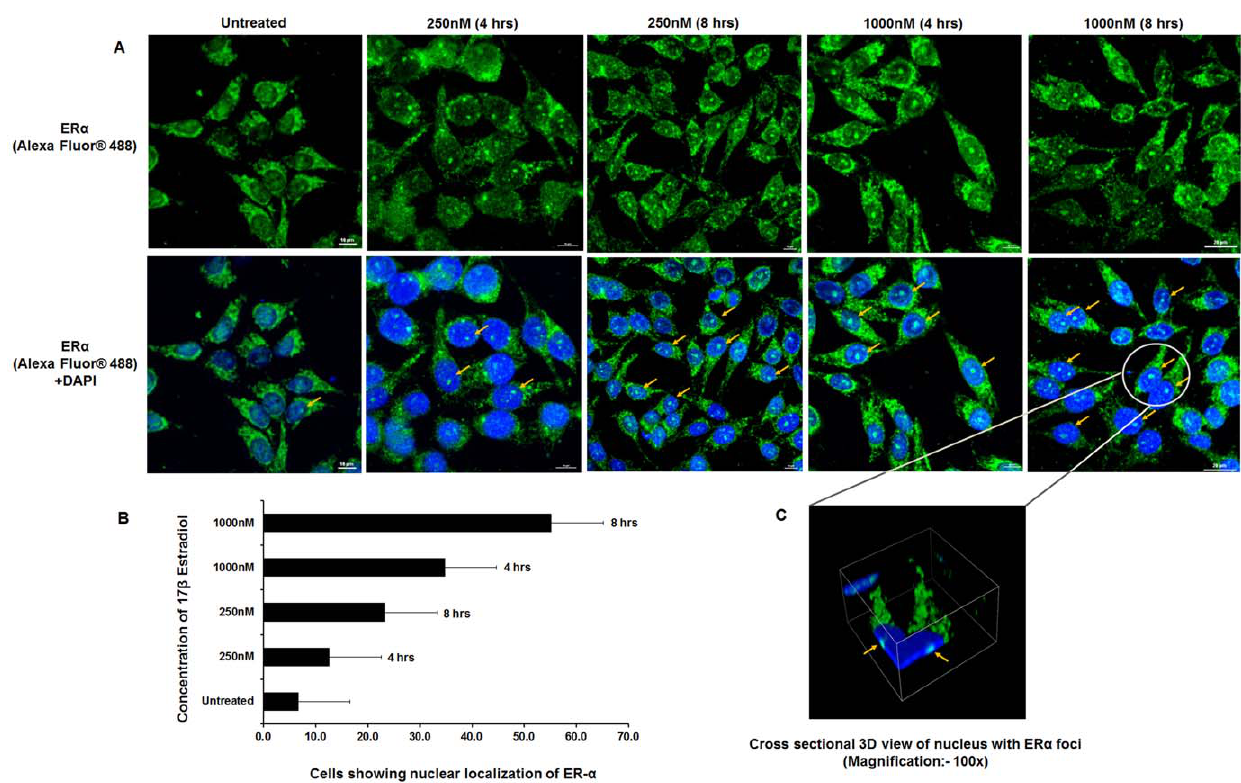
Figure 5. Nuclear localization of ER a upon 17 b estradiol treatment in human RPE cells. A : Confocal images of human RPE cells upon dose (250 mM & 1000 mM) and time (4 hr and 8 hr) dependent treatment with 17 b estradiol. Cells were stained with human specific ER a -antibody followed by Alexa Fluor H 488 labeled anti-rabbit secondary antibody ( Upper panel ). For all conditions, corresponding superimposed image with DAPI are given ( Lower panel ). Arrows point to the cells where nuclear localization of ER a was observed. B : Histogram showing the percentage of RPE cells with ER a localized in the nucleus upon treatment with 17 b estradiol in a dose and time dependent manner. Each experiment was done in triplicate. C : Cross sectional 3D view of nuclear localization of ER a in RPE cell is shown [Scale bar: 10 m m].